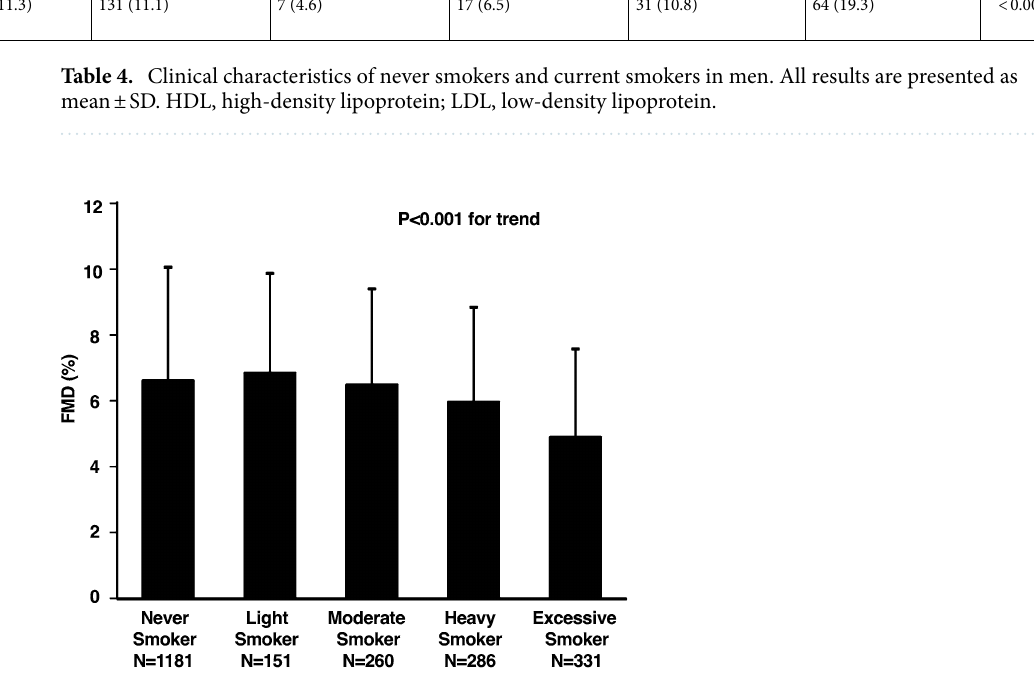
Figure 2. Bar graphs show flow-mediated vasodilation (FMD) in the never smoker group, the lights smoker group, the moderate smoker group, the heavy smoker group and the excessive smoker group in current smokers in